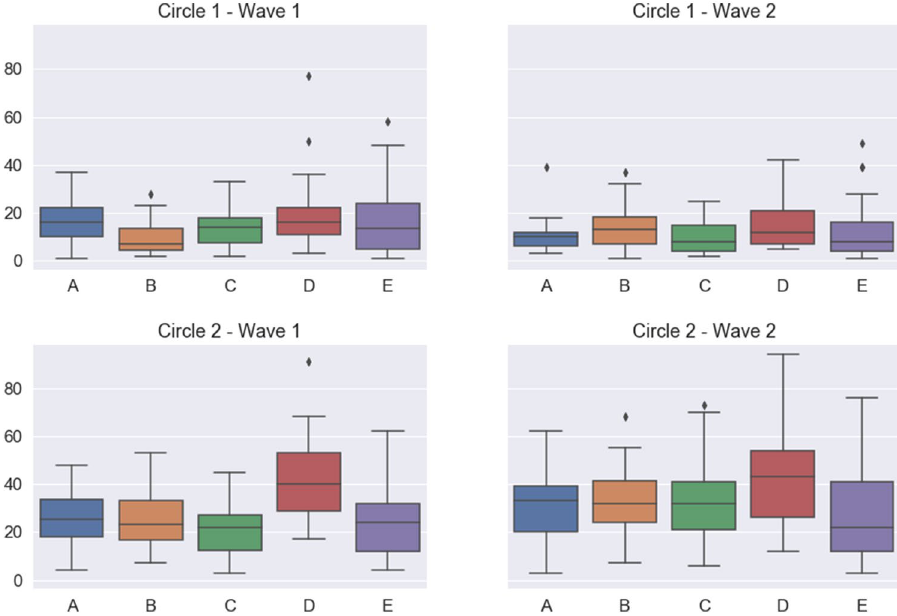
Figure 1. Boxplot of the answers about friendships and very good friendships. Top, numbers of students marked as “best friends” by students of each group (circle 1). Bottom, numbers of students marked as “friends” by students of each group (circle 2). Left, results from wave 1. Right, results from wave 2. Line represents the median, boxes the first and third quartiles, lines, the 95% confidence interval, and dots,